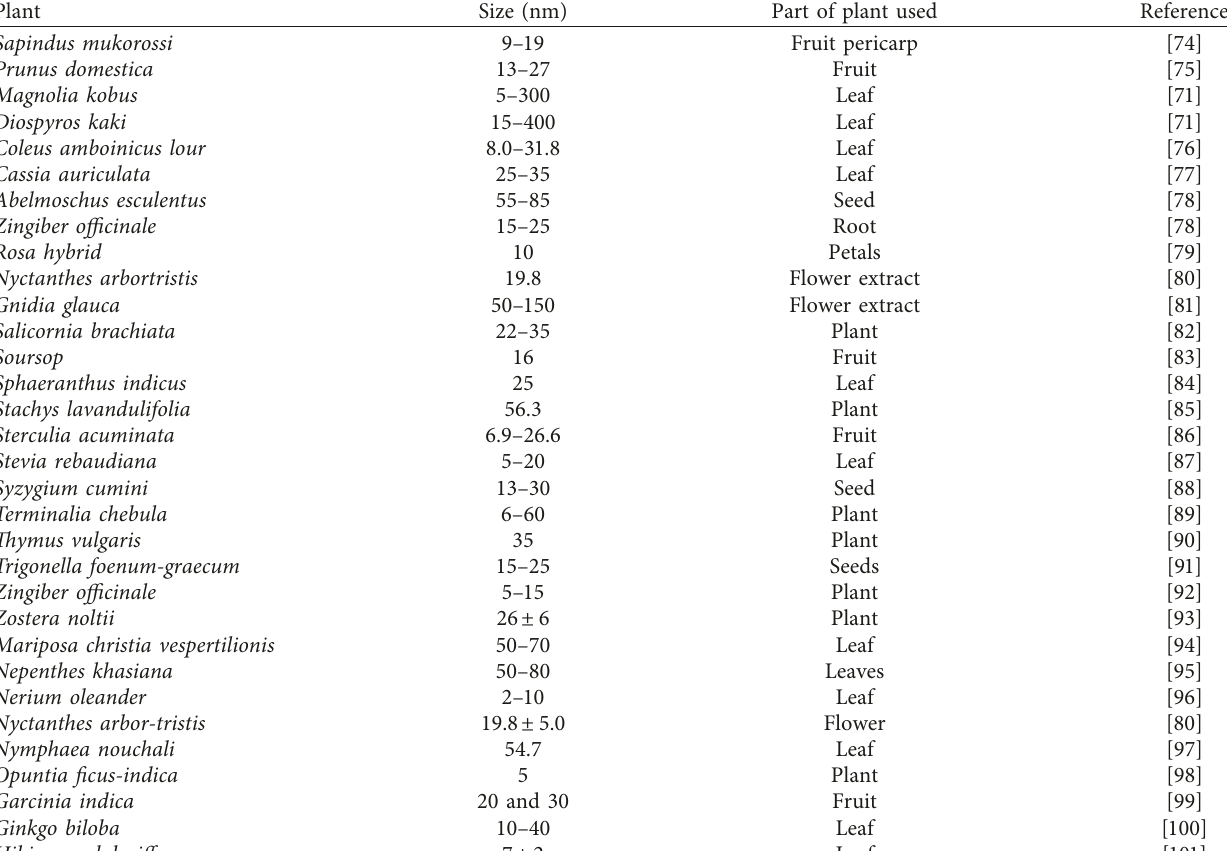
Table 3: Plants synthesize gold